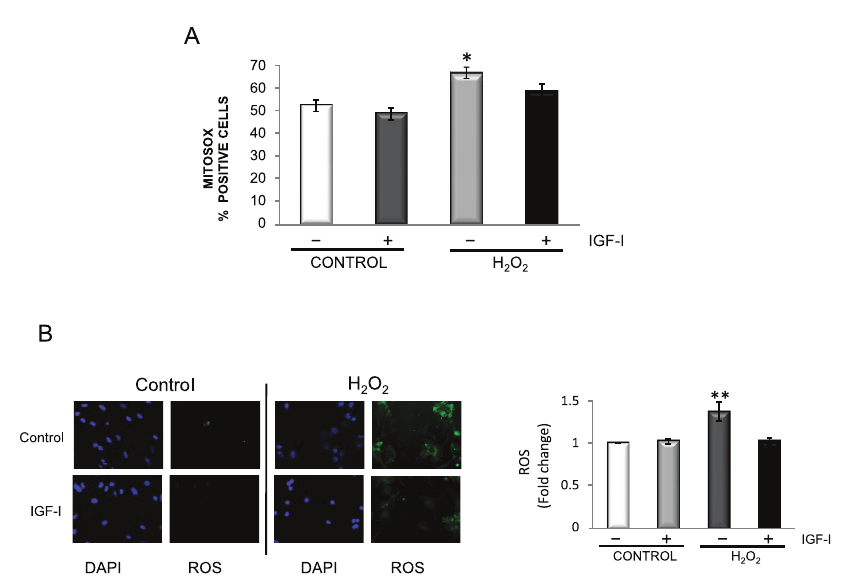
Figure 4. IGF-I reduces oxidative stress in astrocytes. A ) H O increases the number of astrocytes expressing mitochondrial O 2- . This 2 2 increase is prevented when cells are pre-treated with IGF-I. Mitochondrial O 2- levels were detected with MitoSOX by flow cytometry. Astrocytes were treated overnight with IGF-I and for 1 hour more with 200 µM H O (2 way ANOVA, H O and IGF-I interaction: F=1.27; IGF-I p<0.05, 2 2 2 2 F=8.18; H O p<0.01, F=16.18; post-hoc: **p<0.01 H O vs control, *p<0.05 H O vs IGF-I + H O ). B ) IGF-I lowers ROS levels after treatment 2 2 2 2 2 2 2 2 of astrocytes with H O (100 µM). Left: representative photomicrographs of astrocytes stained with carboxy-H DCFDA to detect ROS and 2 2 2 DAPI to stain cell nuclei. The increase in fluorescent cells elicited by H O was markedly diminished by IGF-I. Right histograms: fluorimetric 2 2 quantification of ROS levels with carboxy-H DCFDA confirmed the rescuing action of IGF-I on astrocytes exposed to H O . (2 way ANOVA, H O 2 2 2 2 2 and IGF-I interaction: p<0.05, F=7.38; IGF-I p<0.05, F=5.89; H